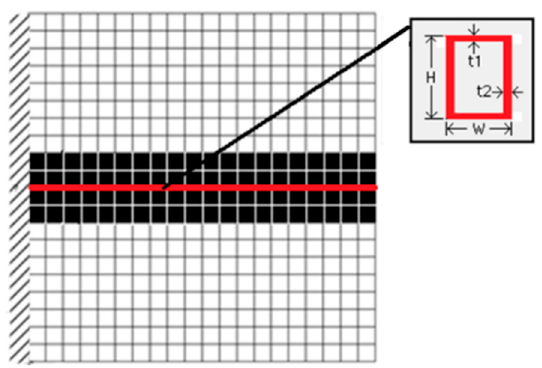
Figure 4. FE model of the stiffened plate.